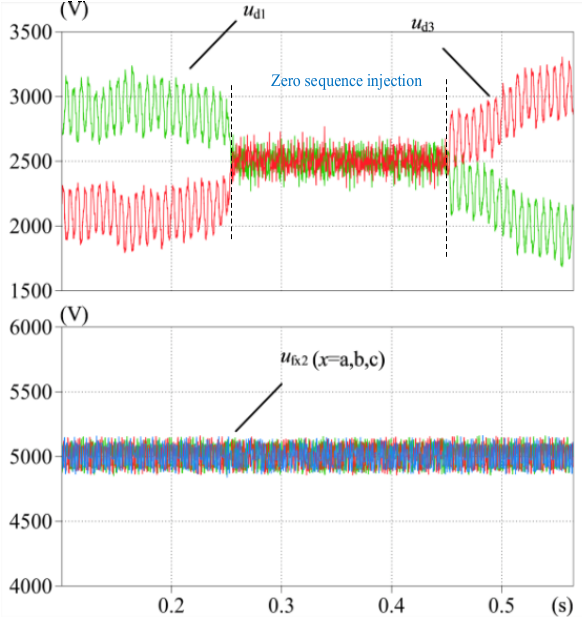
Figure 9. Performance of the feedback control to balance dc capacitor voltages caused by mechanism 3 when C r = 6.